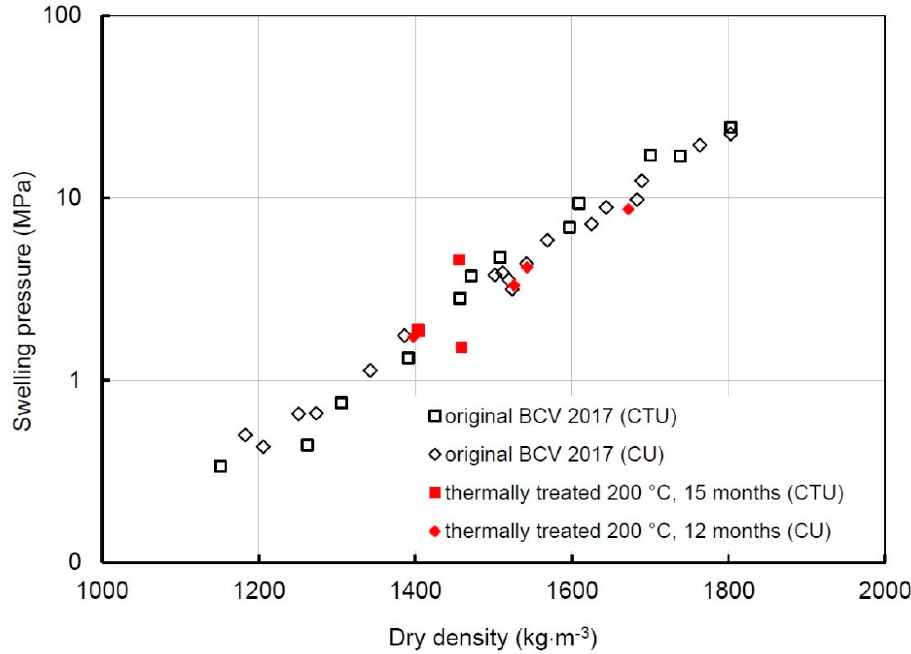
Figure 9. Dependency of swelling pressure on dry density—the original BCV 2017 material in black and the thermally treated material in red. Results were obtained by laboratories at Charles University (CU) and Czech Technical University (CTU).